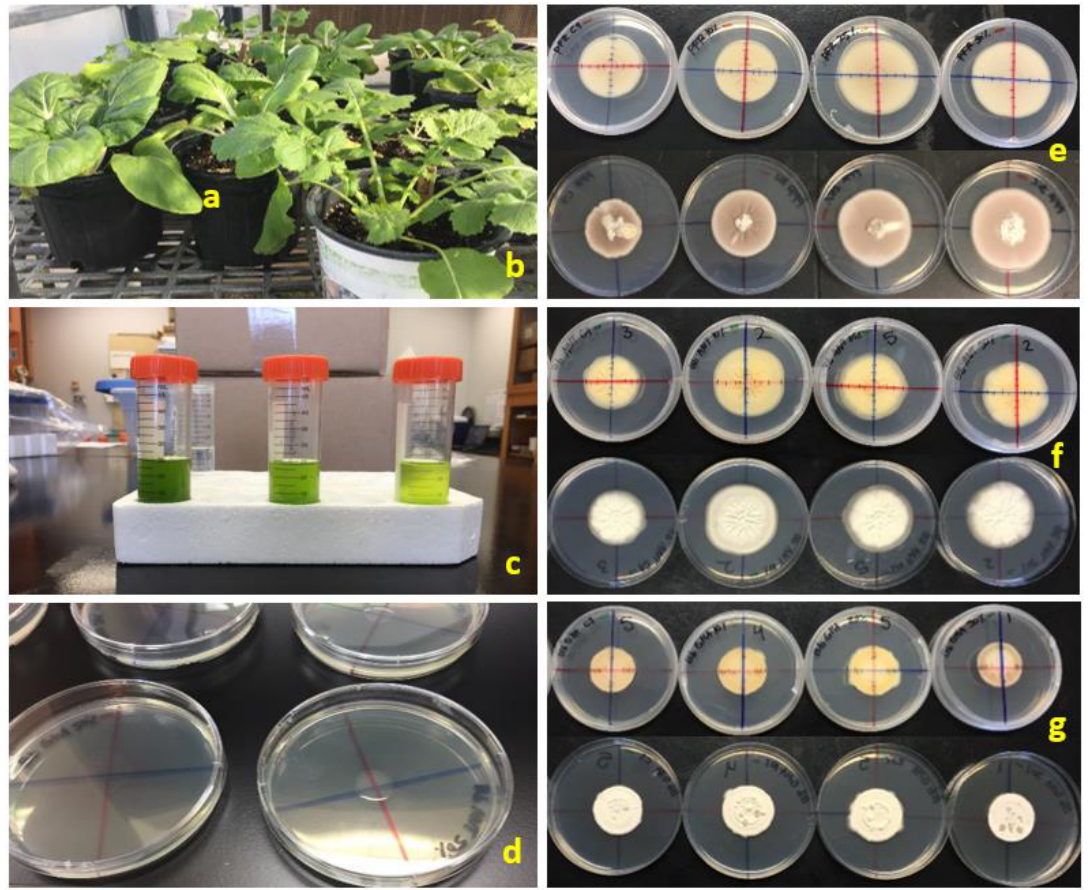
Figure 1. Study preparation and sample results after exposing in vitro two entomopathogenic fungi to leaf extracts from two Brassica rapa subspecies. Materials: ( a ) bok choy; ( b ) turnip; ( c ) supernatant extract concentrations in 50 mL tubes (left to right: 50, 25, and 10%); ( d ) 20 µL inoculation droplet placed in the center of the PDA plate. Radial fungal growth on plates after exposure to 0, 10, 25, and 50% (left to right) plant extract concentrations for 15 days: ( e ) Cordyceps fumosorosea (PFR-97—strain Apopka) with bok choy extract; ( f ) Beauveria bassiana (BioCeres—strain ANT-03) with bok choy extract; ( g ) Beauveria bassiana (BotaniGard—strain GHA) with turnip extract. Top plate sequences in photographs ( e – g ) are of the dish underside with colored perpendicular lines drawn for measuring radial fungal growth over time. Bottom plate sequences in photographs ( e – g ) are of the dish topside.